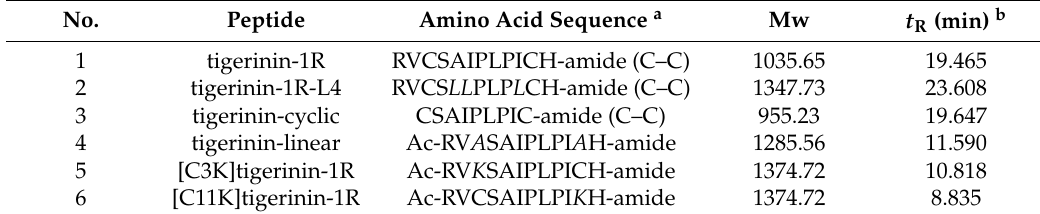
Table 1. Sequence and biophysical data of peptides used in the